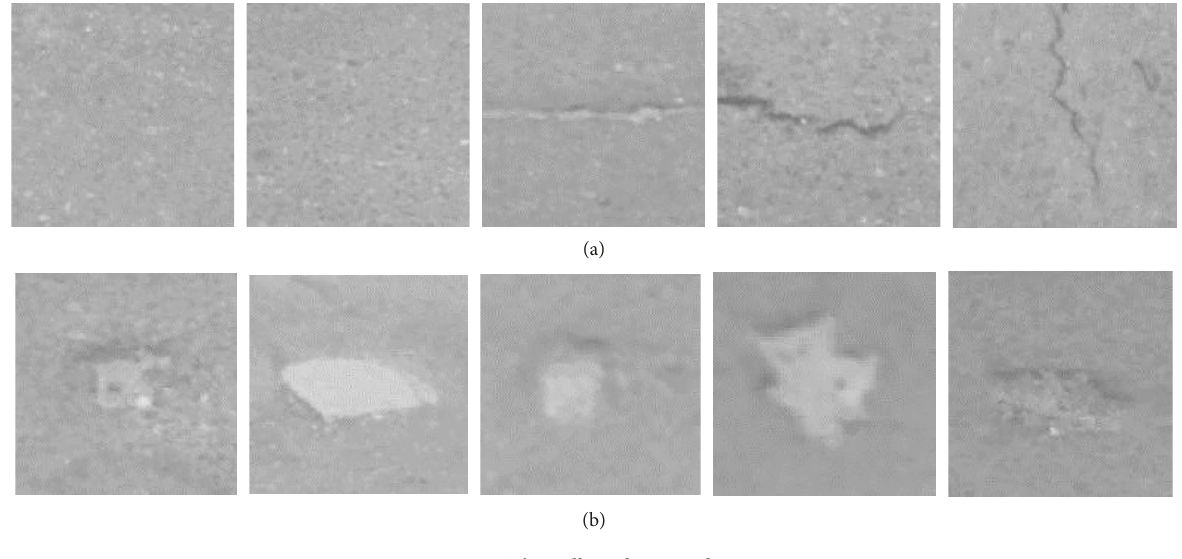
Figure 6: The collected image data set.